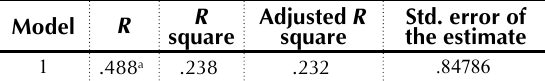
Table 14. ANOVA a Model